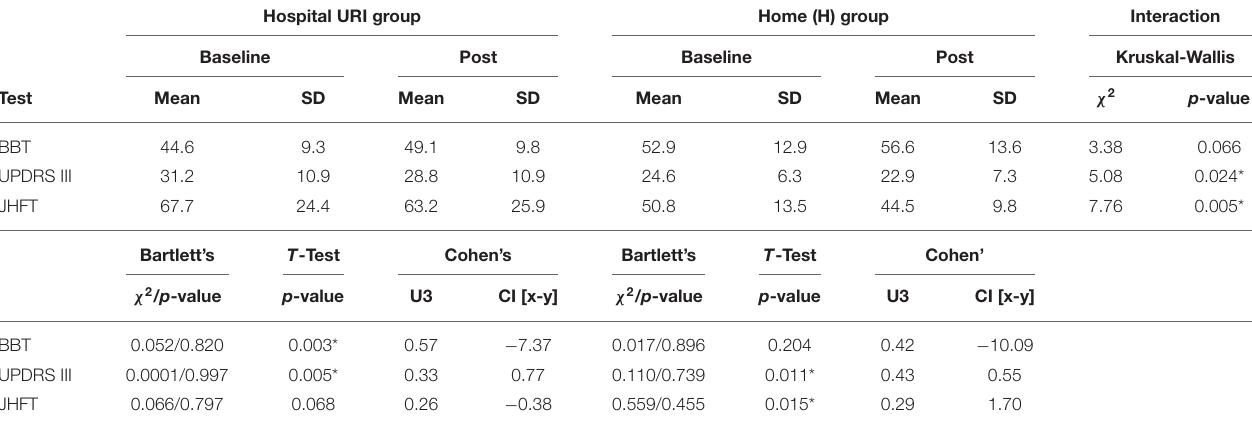
TABLE 2 | Results of the clinical tests in both groups at baseline and post-treatment. Hospital URI group Home (H) group Interaction Baseline Post Baseline Post